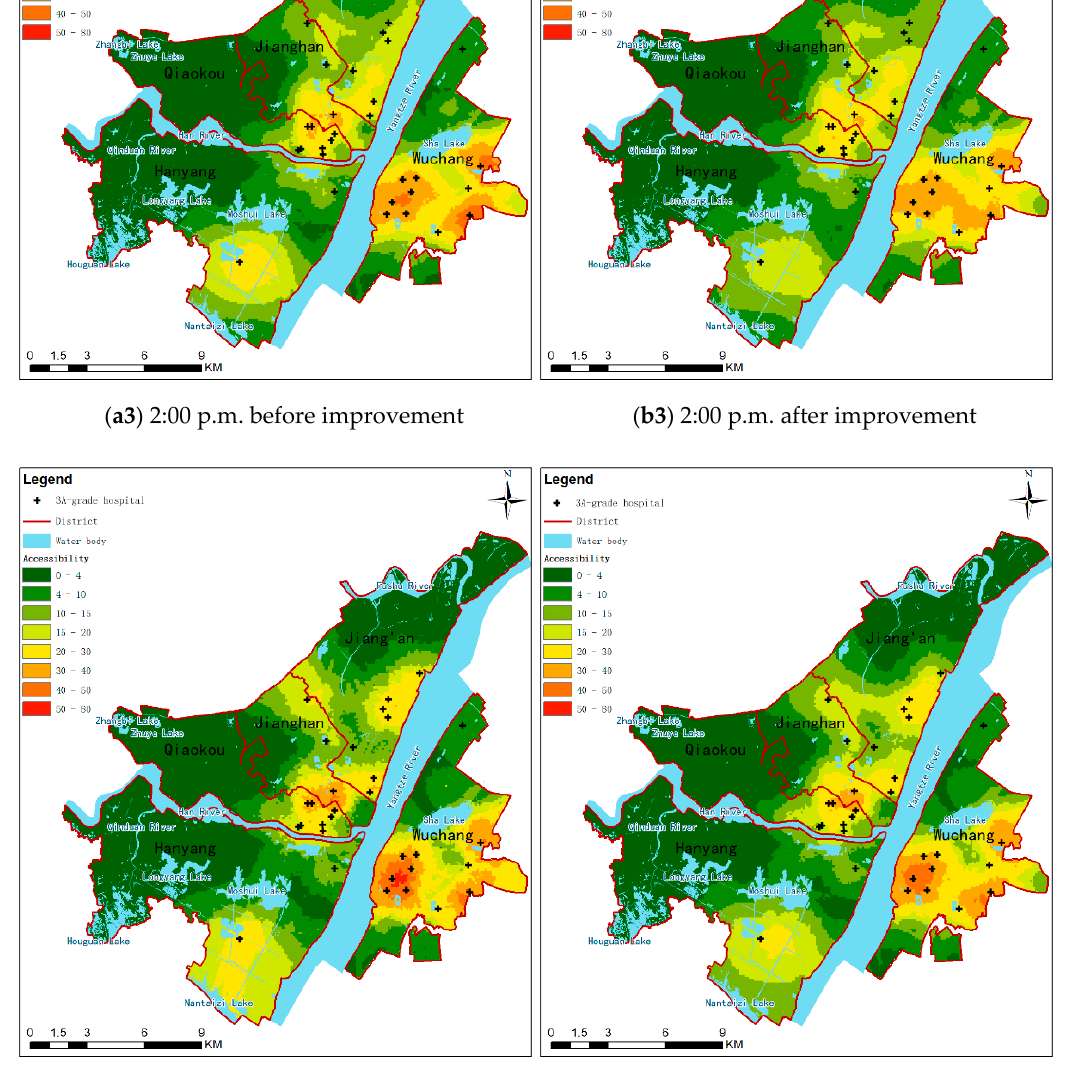
Figure 5. Accessibility of medical facilities at four moments. ( a1 – a4 ) Only time is accounted for ( d t = 15 min). ( b1 – b4 ) Both time and distance are accounted for. ( d t = 15 min, d s = 10 km).